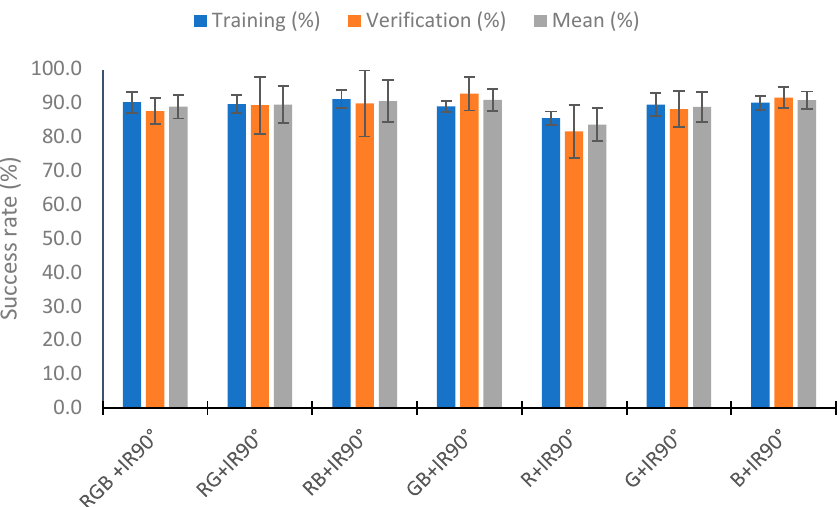
ard deviation of the results that is less.